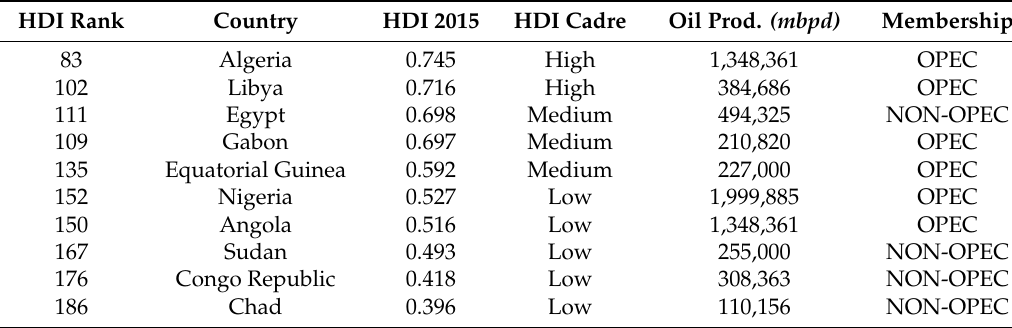
Table 1. World Bank HDI and crude oil production